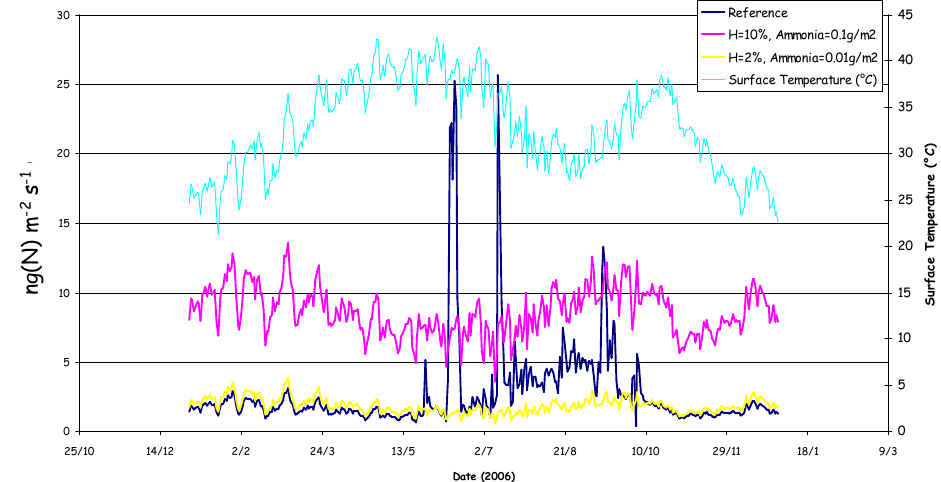
Figure 8. Sensitivity test. In dark blue: reference NO flux in kg ( N ) ha − 1 yr − 1 ; in yellow: NO flux with H = 2% and mineral N = 0.01gm − 2 ; in pink: NO flux with H = 10% and mineral N = 0.1gm − 2 ; in light blue: surface temperature in ◦ C, for year